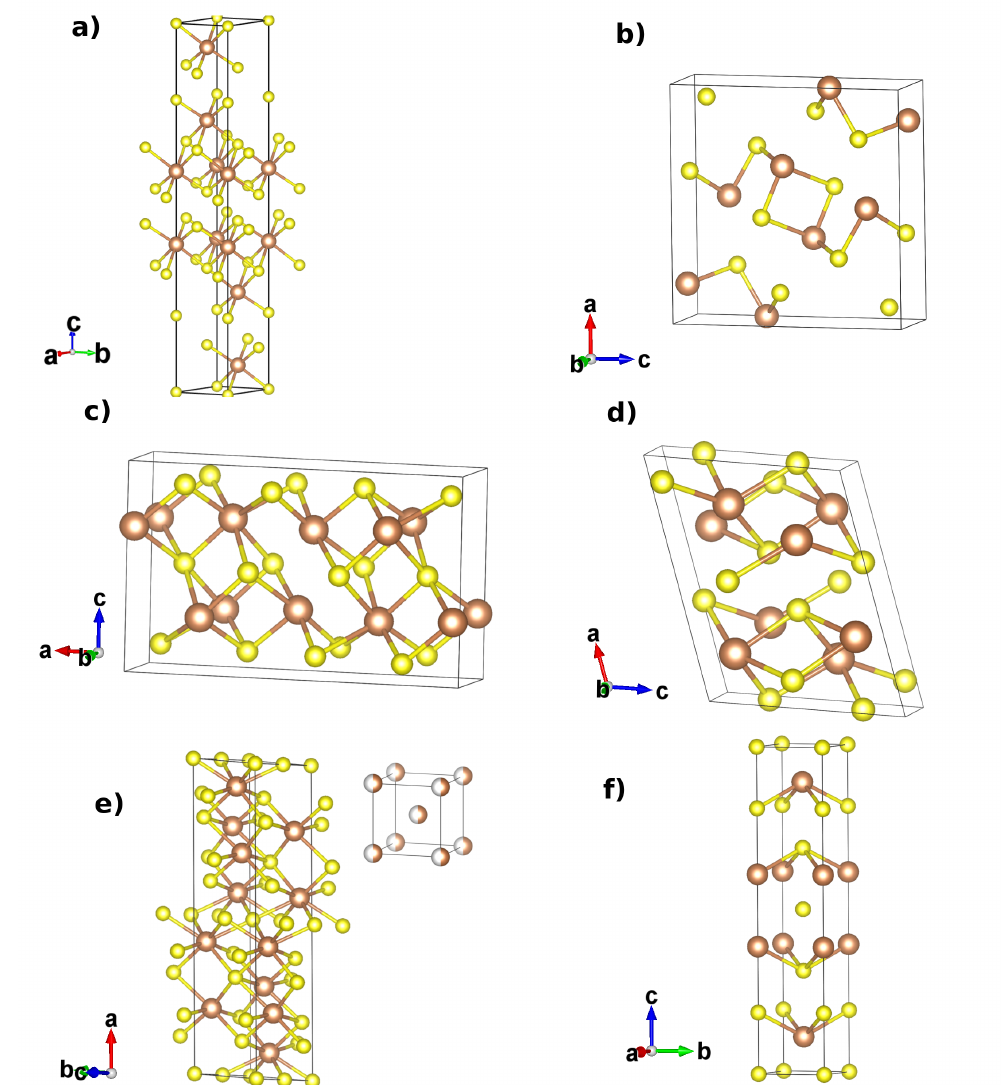
Figure 1. Unit-cell representations of the crystal structures of the R-3m (Z = 1) ( a ), Pnma (Z = 4) ( b ), C2/m (Z = 2) ( c ), C2/c (Z = 2) ( d ), the C2/m 9-/10-fold structure used to model the disordered bcc-type Im-3m phase (Z = 2) ( e ), and the I4/mmm (Z = 1) ( f ), and A 2 X 3 sesquichalcogenide structures (A = Sb, Bi; X = S, Se). The A cations and X anions are shown as brown and yellow spheres,